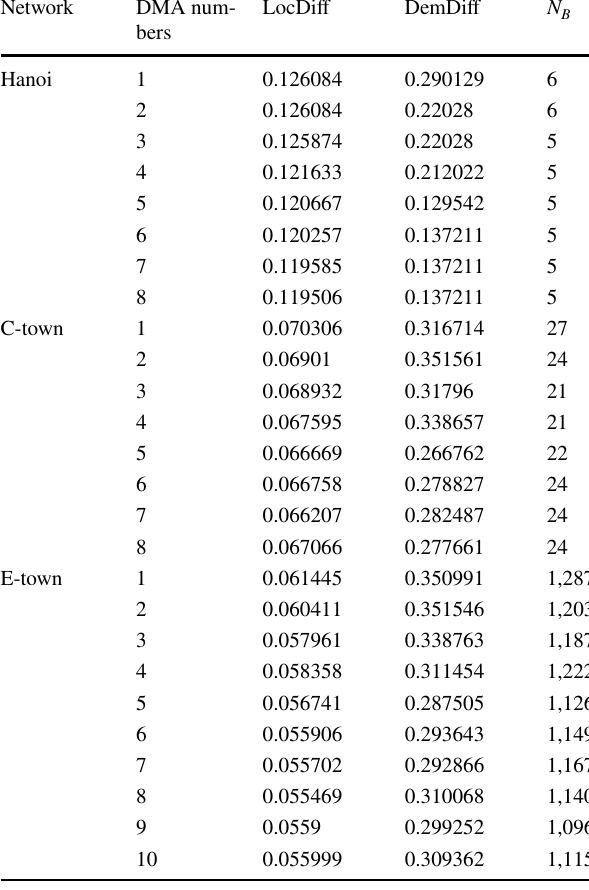
Table 4 Effect of aggregation range on clustering results (DMA num- bers to 4, 7, and 160) Network DMA num- bers